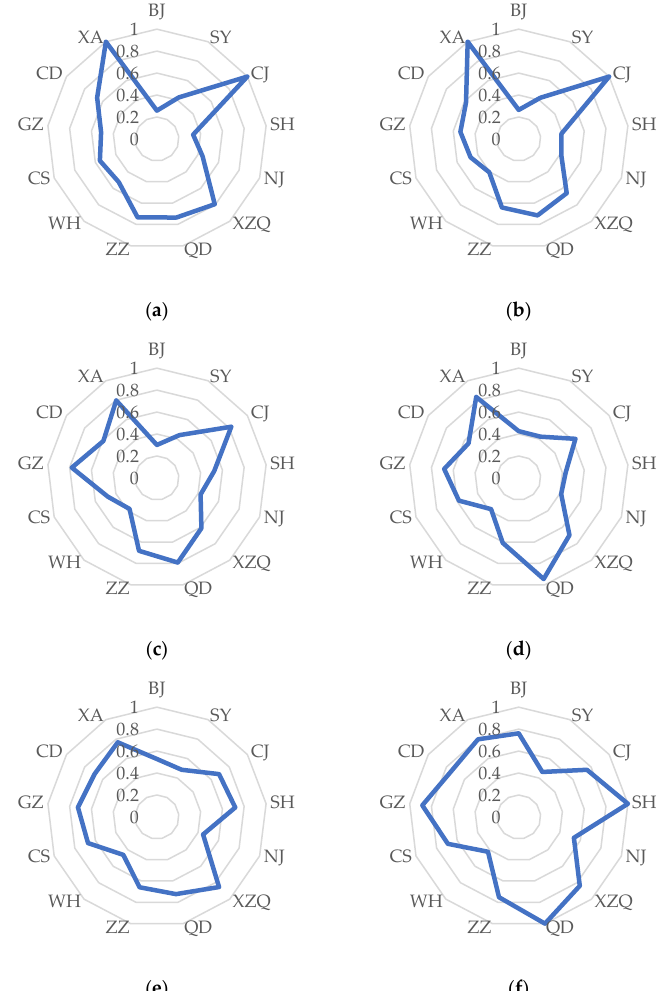
Figure 3. Evolution trend of the ECILUs in 2007–2018.